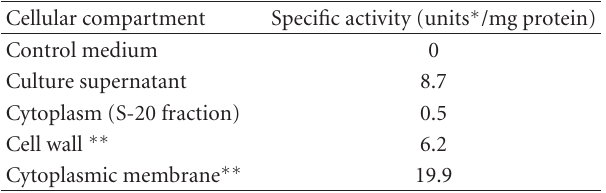
Table 2: Distribution of TUAS activity in subcellular extract of M.